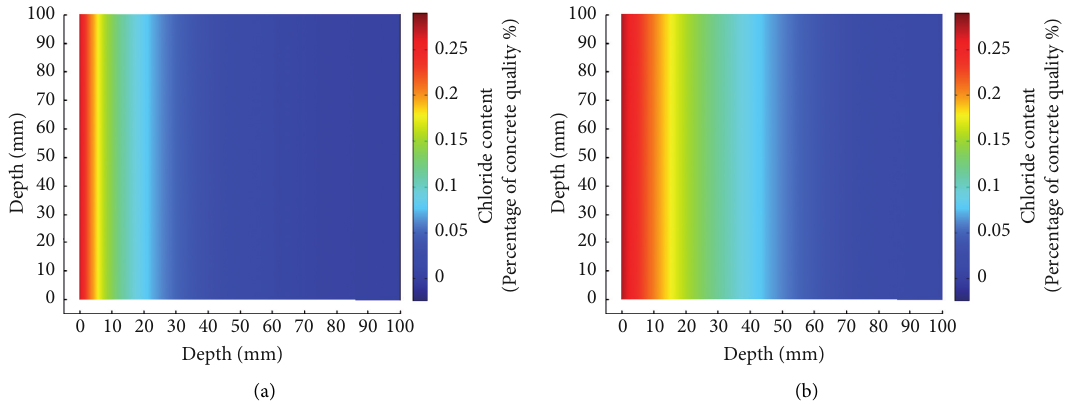
Figure 15: Comparison of chloride coupling migration and pure diffusion in chloride transport model: (a) coupled moisture desorption, saturation 0.9; (b) pure diffusion, saturation